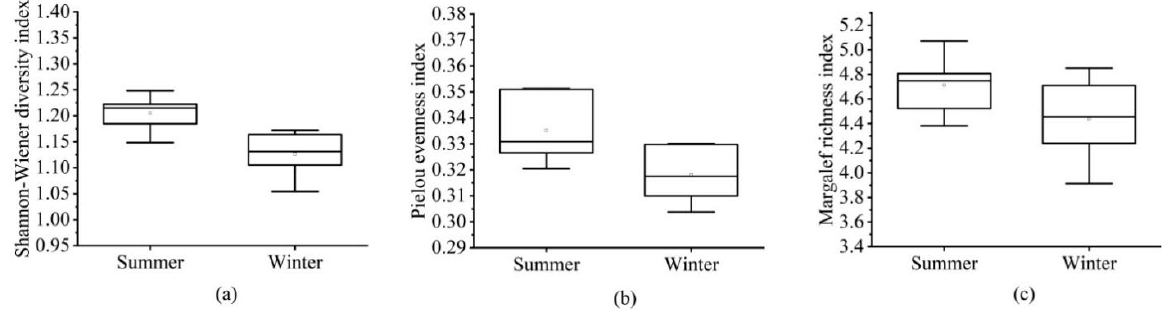
Figure 4. Biodiversity index of periphytic algae. Shannon–Wiener diversity index ( a ), Pielou evenness index ( b ), Margalef richness index ( c ).